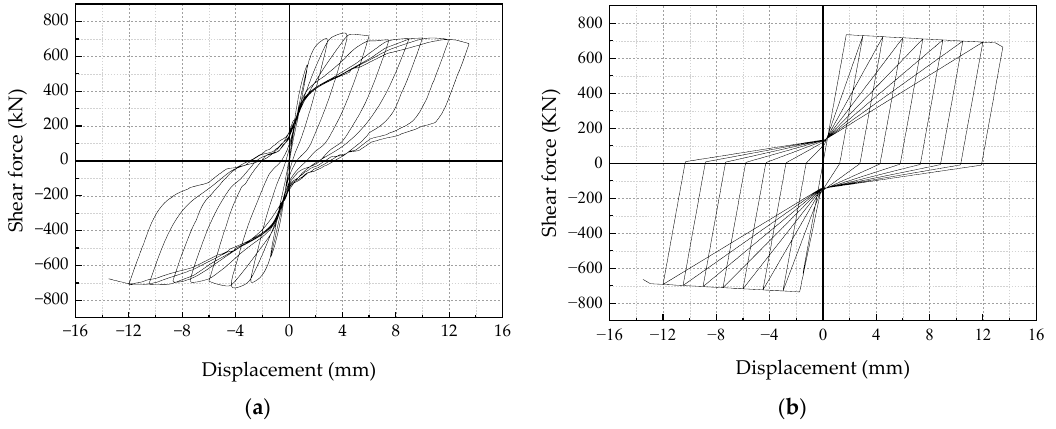
Figure 10. Hysteretic curve of the ECC short column. ( a ) SMMECC model; ( b ) IMK model.